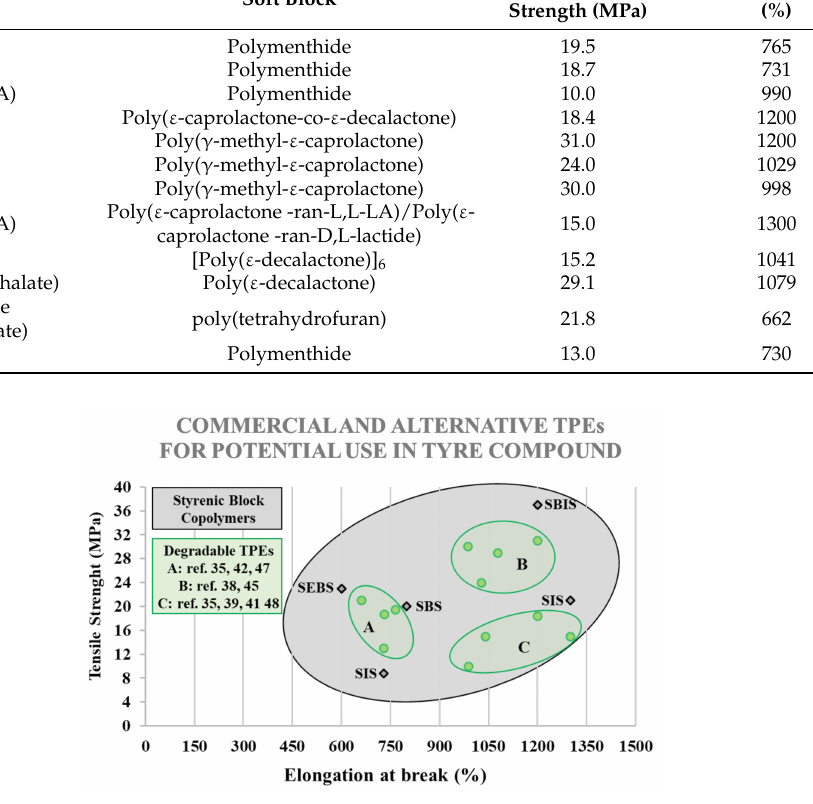
Figure 7. Comparison of the mechanical properties of degradable TPEs with the commercial non- degradable